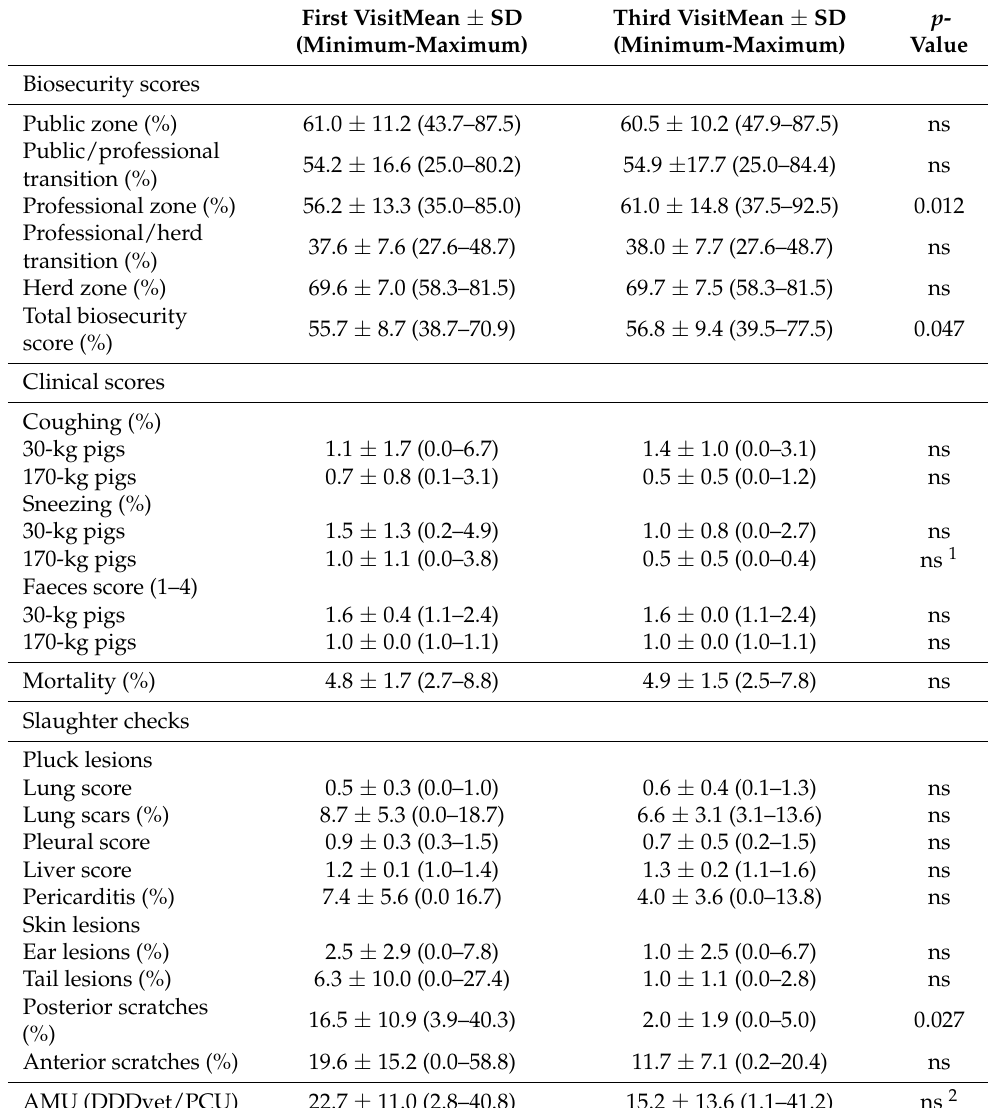
Table 3. Descriptive analysis of the farms (n = 15) at the beginning and at the end of the study: biosecurity scores for each zone, clinical scores, mortality per year, slaughter checks, and antibiotic